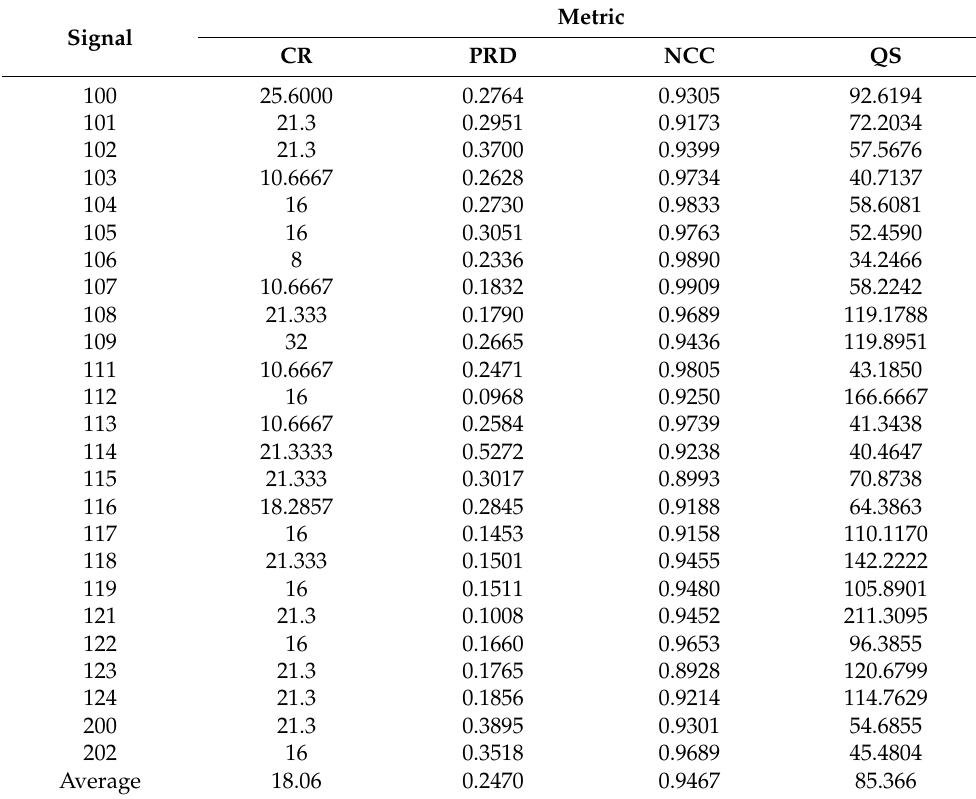
Table 1. Result of ECG signal compression using the proposed